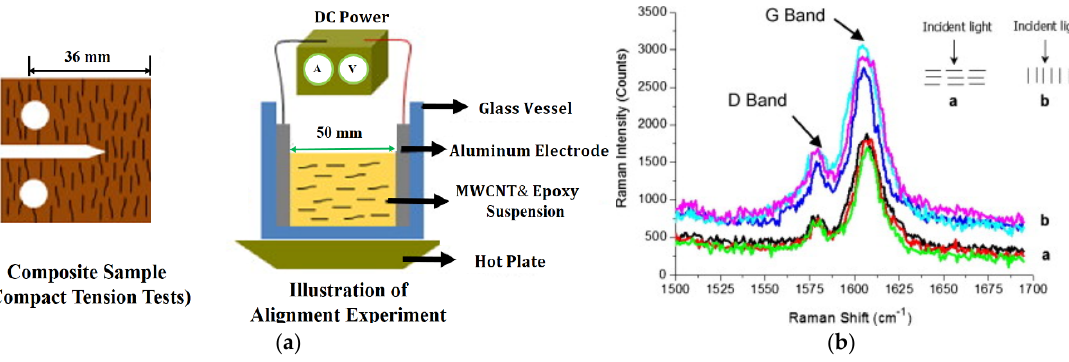
Figure 11. Alignment of MWCNT in epoxy nanocomposites ( a ), and Raman spectra of aligned MWCNT/epoxy composites, showing different G-band peak intensities as the change of the direction of applied polarized light against the CNT alignment ( b ) [41].